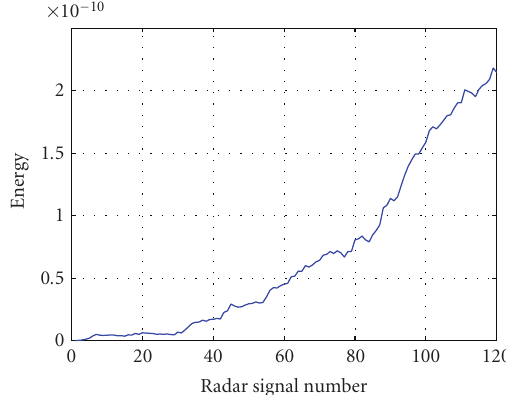
Figure 2: Example of the curve of energy collection (measured da-